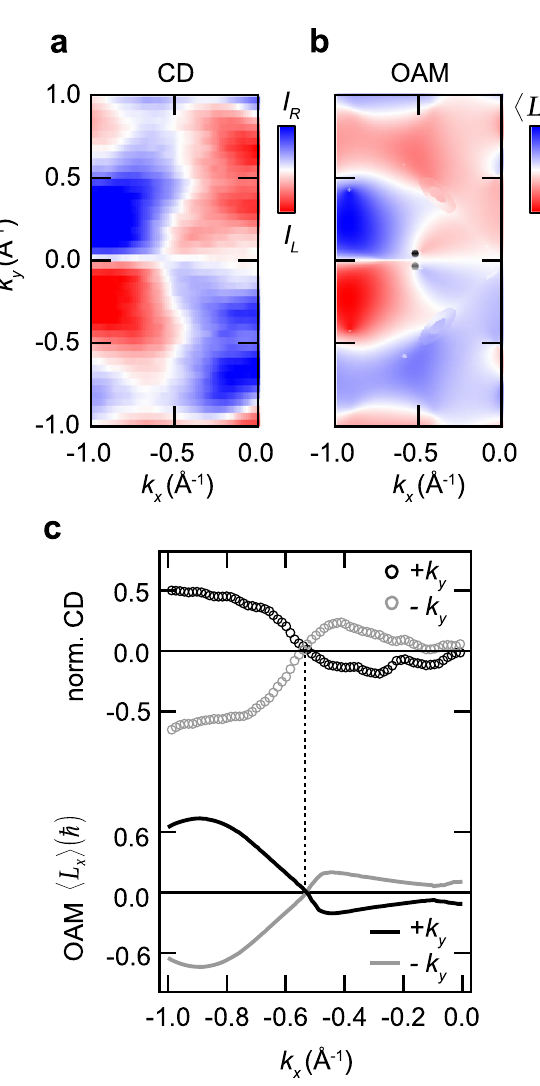
Fig. 3 Momentum-space texture of circular dichroism and orbital-angular momentum. a , b Momentum distributions of measured circular dichroism (CD) and calculated L x component of the orbital-angular momentum (OAM) at k z ¼ (cid:2) 0 : 59 2 π c , corresponding to the W 2 Weyl nodes. The data sets were obtained by integrating over an energy range from 0 eV to − 1.2 eV, the width of the bands v ± (cf. Fig. 2a). The calculated positions of the W 2 Weyl nodes are indicated in b . The CD-ARPES data were acquired at h ν = 590 eV. c CD signal normalized to the total photoemission intensity and L x component of the OAM along k x cuts through Weyl nodes of opposite chirality. Sign changes are observed near the Weyl